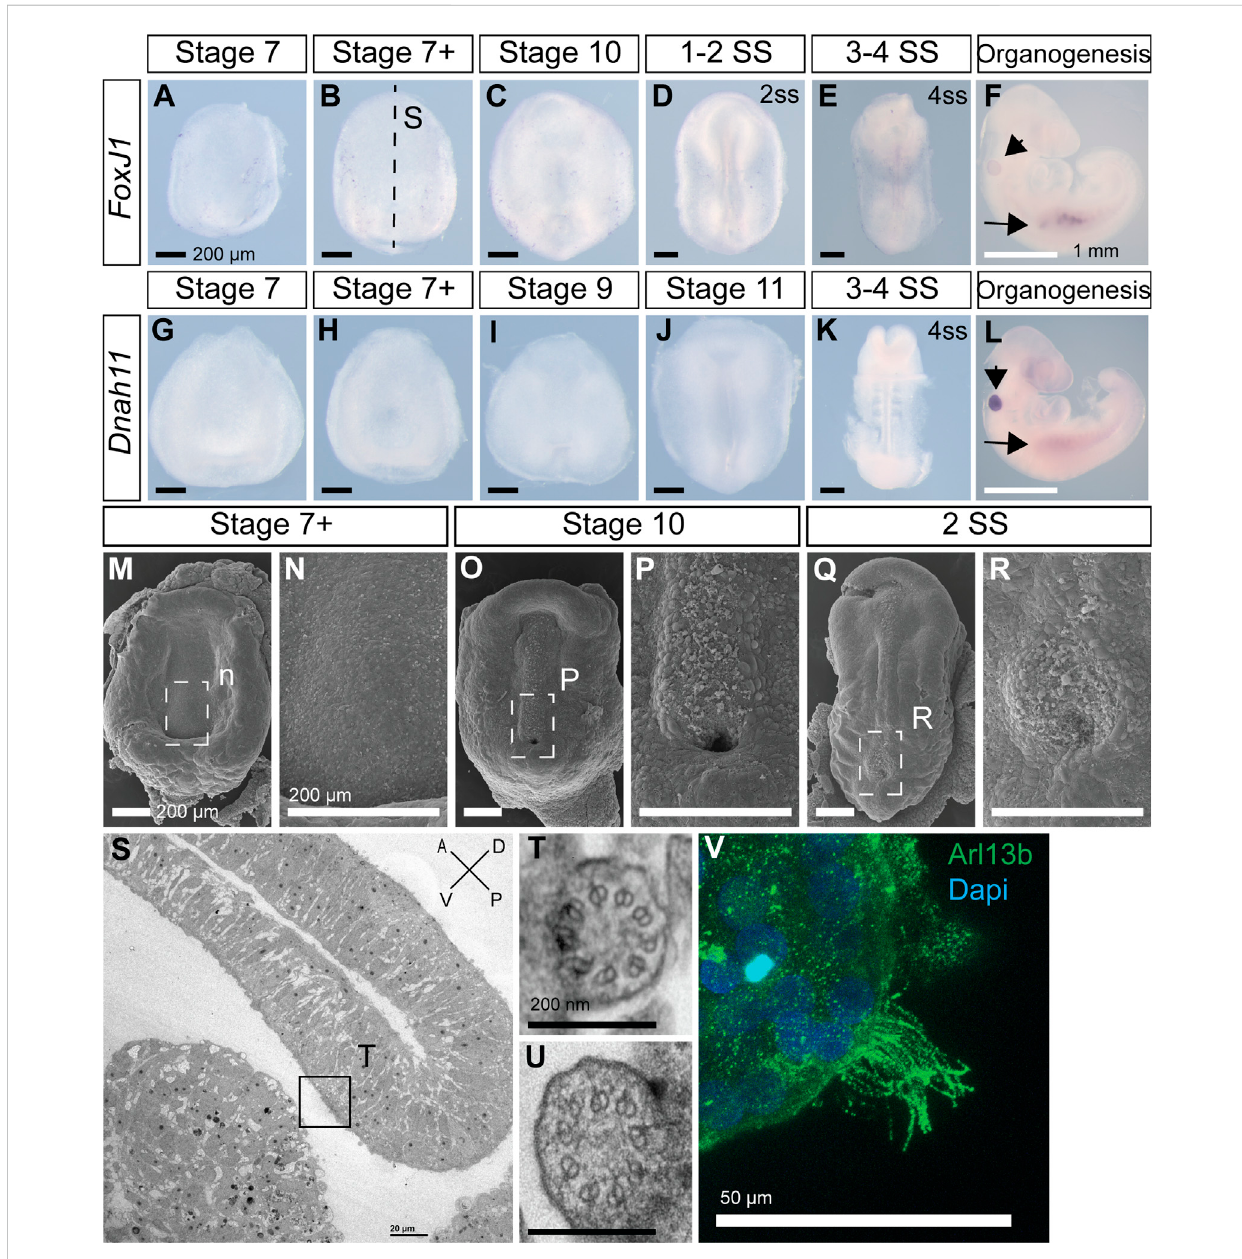
FIGURE 4 VeiledchameleonembryoslackmotileciliaduringL-Rasymmetryestablishment.Allembryosarepresentedinventralview,unlessotherwisenoted. DorsalviewavailableinSupplementaryFigureS5,wherepossible. (A – F) WholemountRNA insitu hybridizationfor FoxJ1 expression. (G – L) Wholemount RNA in situ hybridization for Dnah11 expression. (F, L) Arrowheads indicate gene expression in otic vesicle, arrows indicate gene expression in the kidney — bothareasknowtohavemotilecilia.Blackscalebarsin (A – E,G – K) are200 μ m.Whitescalebarsin (F,L) are1 mm. (M – R) SEMvisualization of embryos. Dashed rectangular areas in (M, O, Q) are enlarged in (N, P, R) . All scale bars in (M – R) are 200 μ m. (S – U) TEM images. (S) Sagittal section through an embryo, as indicated with a dashed line in B for a stage-matched embryo. Embryo orientation is as indicated, with blastoporal lip located dorsally.Scalebar20 μ m.Boxedregionindicatesexactlocationofthecilium,depictedin T.(T,U) .Crosssectionsoftwocilia,locatedneartheblastopore, asindicatedinS.Bothciliahave9+0structureandlackaxonemaldyneins,pointingtotheirnatureasprimary,non-motilecilia.Scalebarsare200 nm. (V) Fluorescent immunostaining of motile multicilia in dissociated kidney cells. Ciliary marker Arl13b is in green, nuclei labeled with Dapi in blue. Video of ciliary movement is available in Supplementary Video S1. Scale bar is 50 μ m.